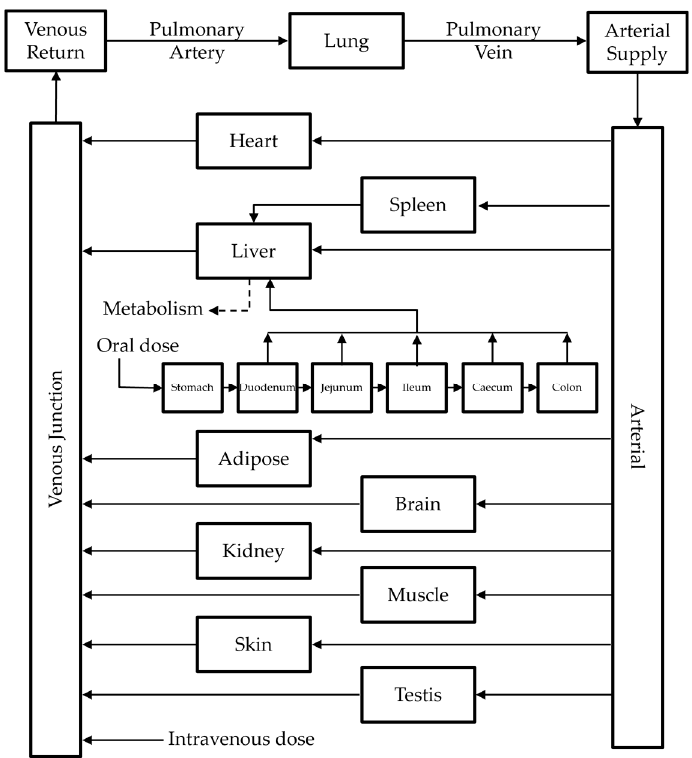
Figure 2. PBPK model structure applied for the IDP-73152 PK in mice, rats, dogs, and humans.